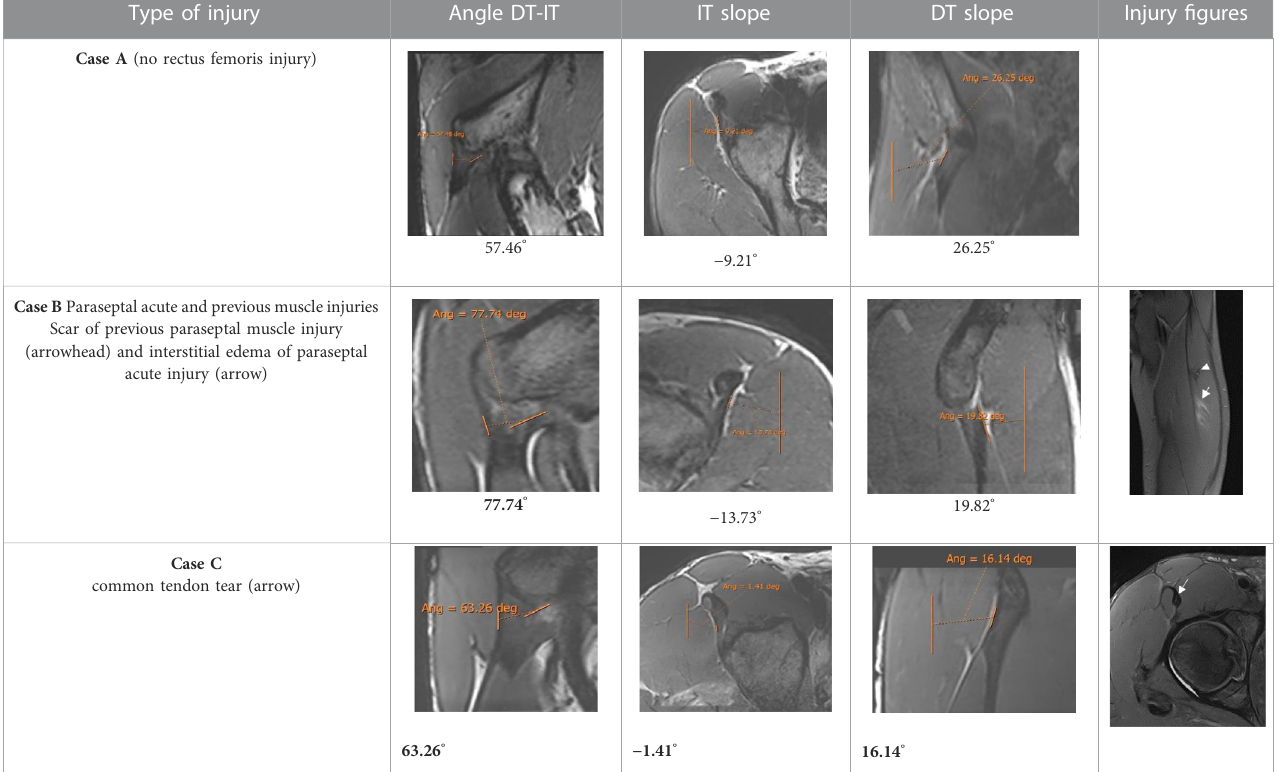
TABLE7DT-ITangle,ITslope,andDTslopeinonemalefootballplayerwithnorectusfemorisinjuryandtwomalefootballplayerswithdifferentrectusfemorisinjuries. Bold values are outliers. DT, direct tendon; IT, indirect tendon. Type of